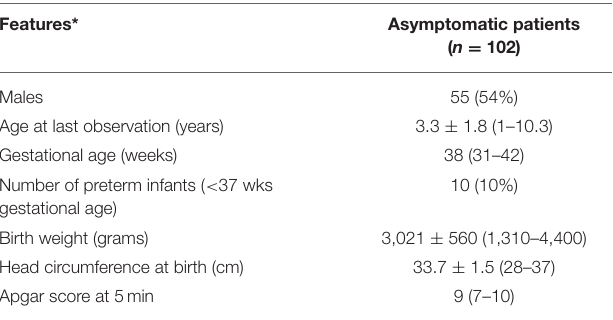
TABLE 3 | Demographic and clinical features at onset in patients with cCMV asymptomatic infection. Features*